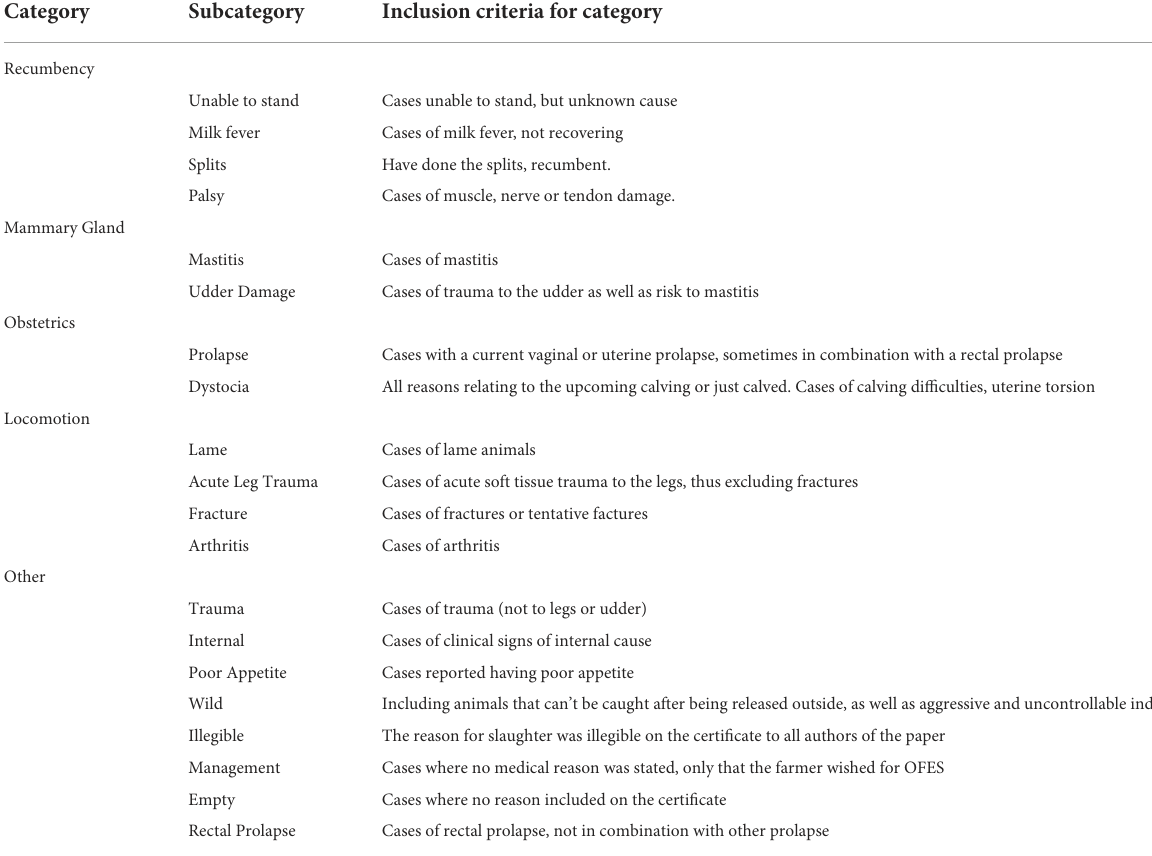
TABLE 1 Inclusion criteria for categories of reason for OFES, including the sorting of subcategories to categories.